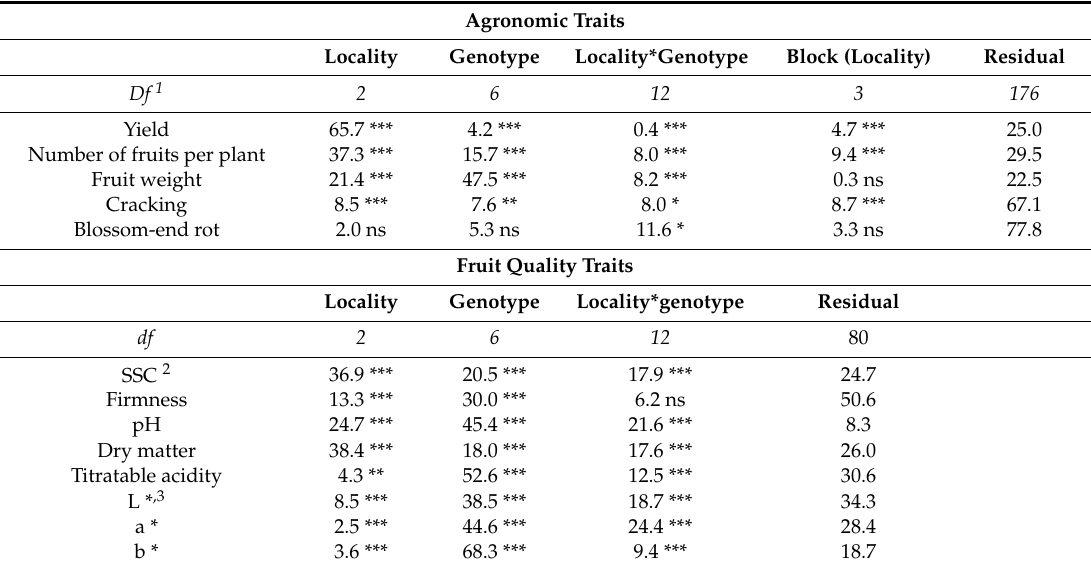
Table 3. Percentage of the total sums of squares and significance for the factors considered in the ANOVA model for agronomic and fruit quality